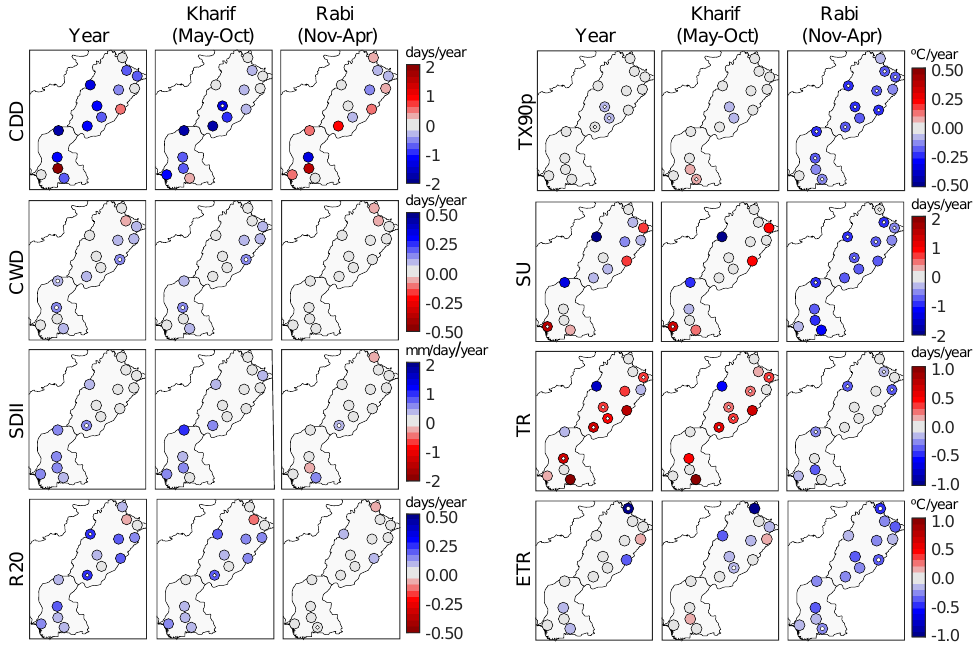
Figure 5. Observed annual trends for the temperature- and precipitation-based extreme indicators listed in Table 3 ( left and right panel, respectively) over the period 1997–2016. Significant (95% confidence level) trends are marked with a white